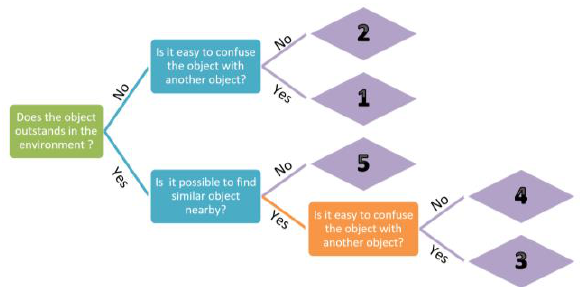
Figure 2. Decision tree for the Uniqness